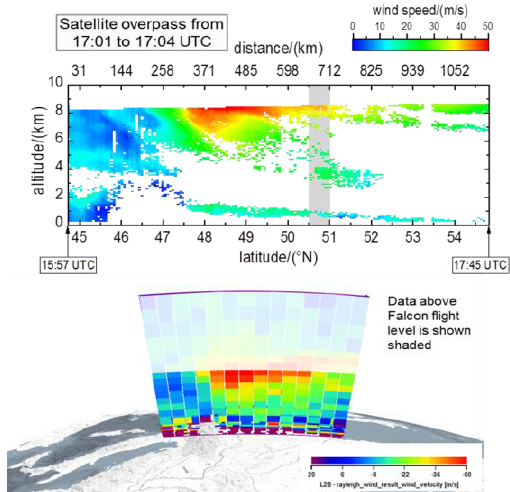
Figure 4 First airborne validation of L2b Rayleigh winds with 2-µm wind lidar (top) from 17 November 2018. Aeolus data (bottom) is visualized by VirES